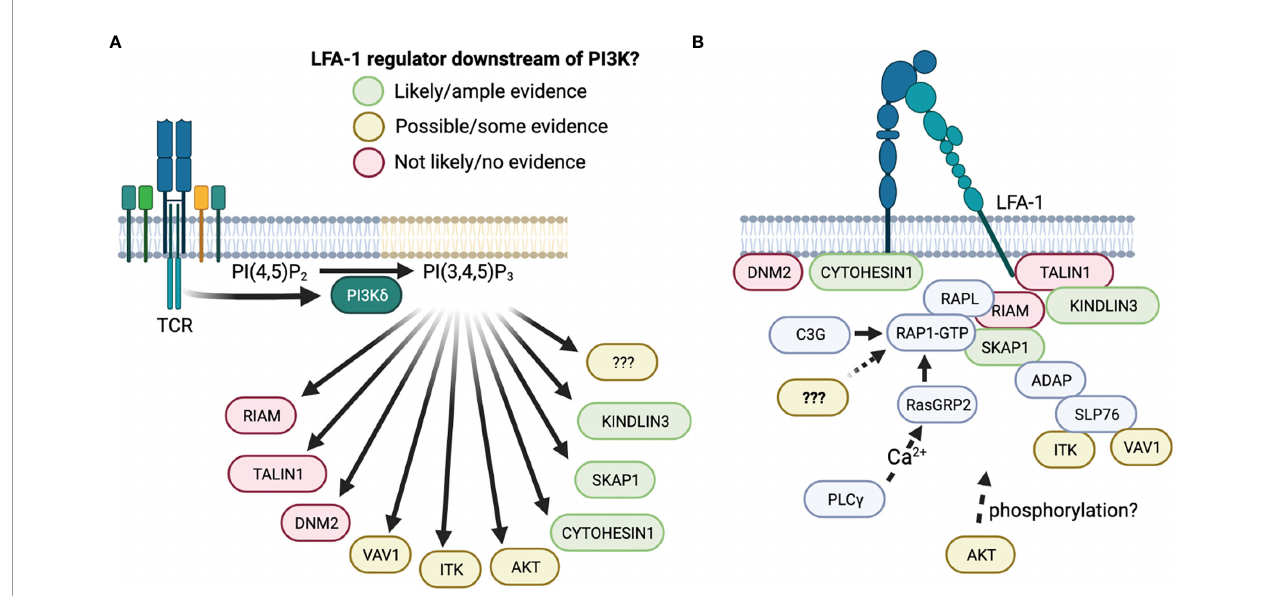
FIGURE 4 | LFA-1 regulators downstream of PI3K d . (A) Schematic of proteins that have been implicated in LFA-1 regulation, and the likelihood that they are regulated by PI3K based on the literature. Green proteins have ample evidence that they are regulated by PI3K and have been implicated in LFA-1 regulation in multiple studies. Orange proteins have some evidence suggesting that PI3K regulates their functions and are to some extent involved in LFA-1 regulation. Red proteins have PH domains, but are unlikely to be regulated by PI3K due to low PIP 3 af fi nity. It is important to note that PIP 2 is up to 100X more abundant on the plasma membrane than PIP 3 (131). Therefore, a given protein needs to have high selectivity for PIP 3 over PIP 2 in order to be directly regulated by PI3Ks. (B) Simpli fi ed schematic of how the proteins in (A) are involved in regulation of LFA-1, showing interaction partners and approximate location. Figure made in